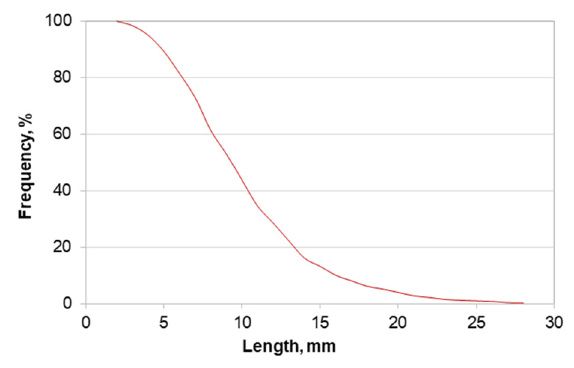
Figure 4. Length distribution of RTPFc [12].